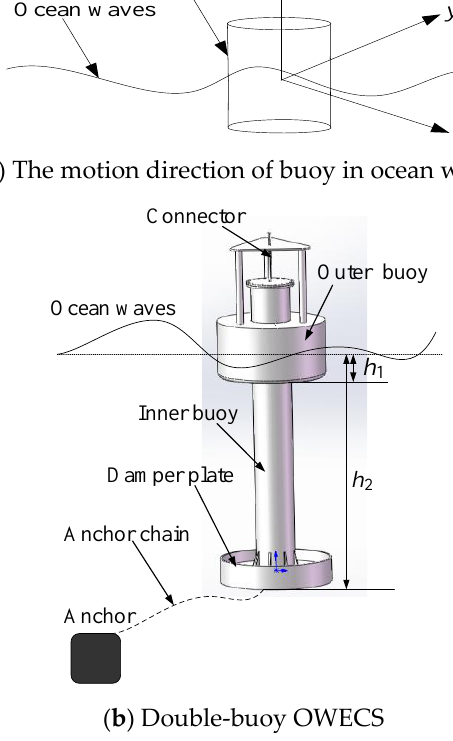
Figure 2. The operational principle of double-buoy OWECS.